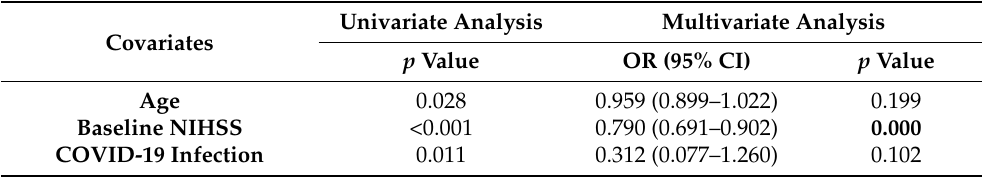
Table 4. Logistic regression model on the likelihood of favorable functional outcome (mRS 0–2) on discharge ( n = 61).